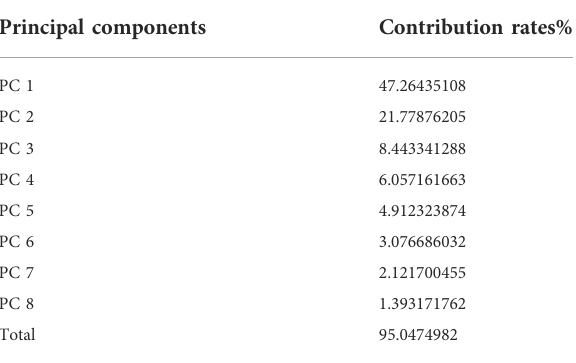
TABLE 1 Principal Components and their contribution rates (PCA was performed on the matrix consisting of descriptors without molecular interaction-based